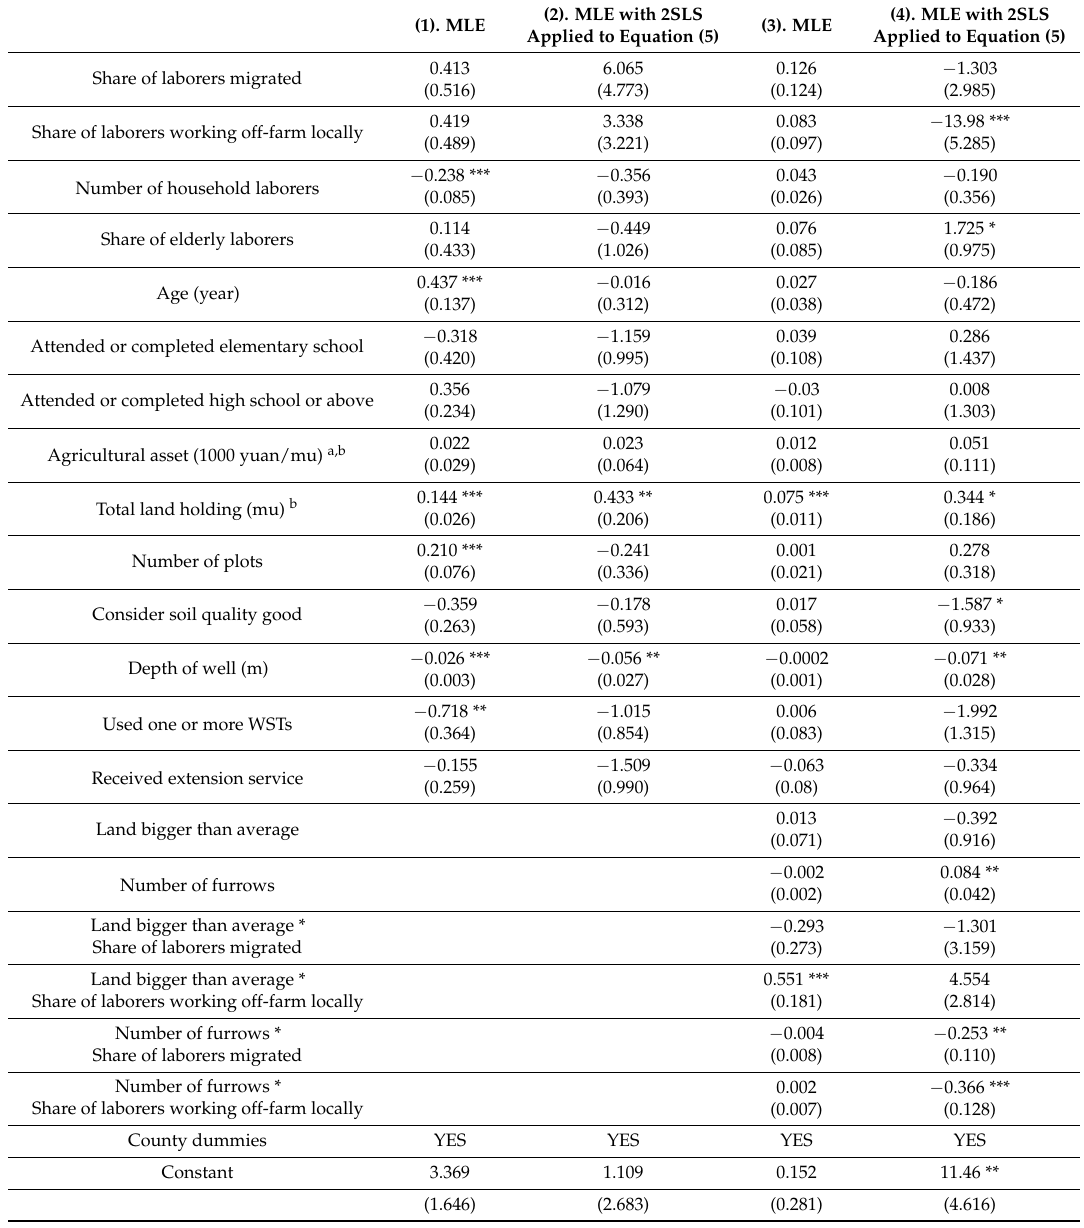
Table 4. Factors that may influence irrigation water